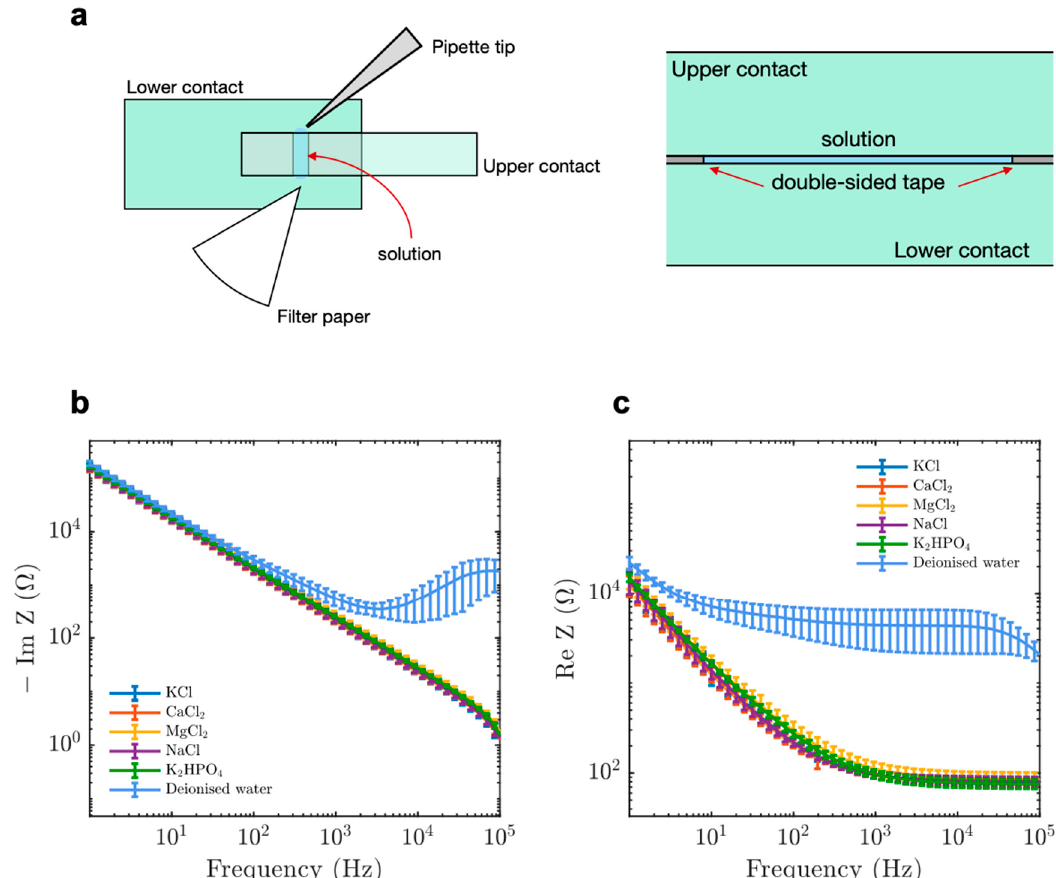
Figure 1. A parallel-plate contact device to measure the impedance properties of microtubules (MTs) compared to tubulin. The operation of the parallel plate device showing ( a ) top view (left) and side view (right). The upper and lower contacts, double-sided tape and solution are labelled in green, grey and blue, respectively. ( b ) Imaginary component of impedance for electrolytic solutions at 100 mM and de-ionised water. ( c ) Real component of impedance for electrolytic solutions at 100 mM and de-ionised water. Data display average values collected between 15 and 21 times. Error bars represent standard deviation.